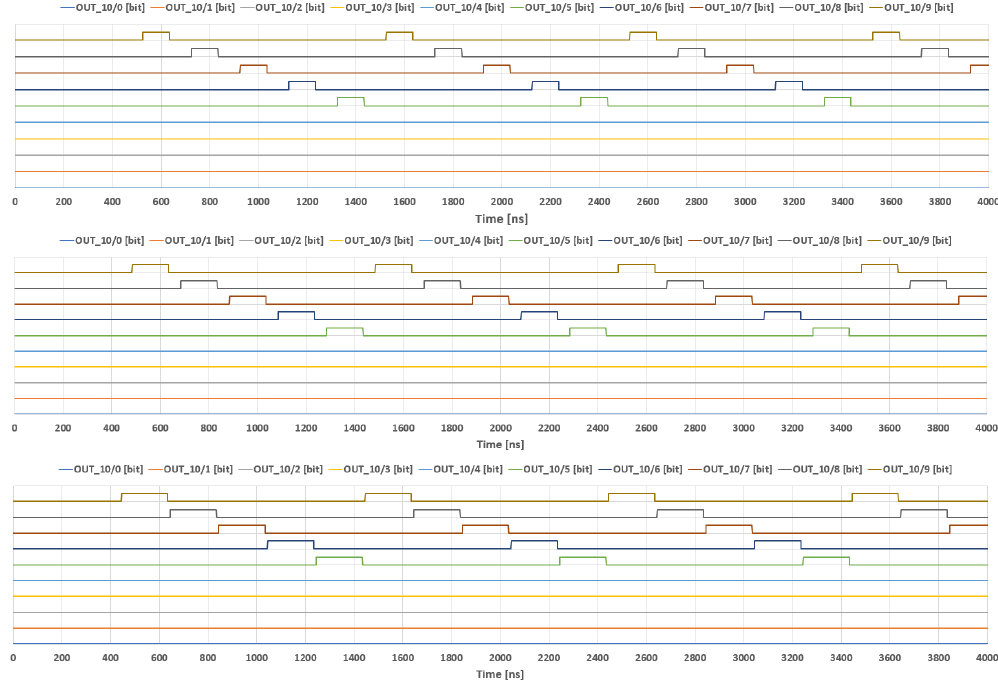
Figure 11. Measurement results of the clock generator with five phases, for different widths of the clock pulses (fill